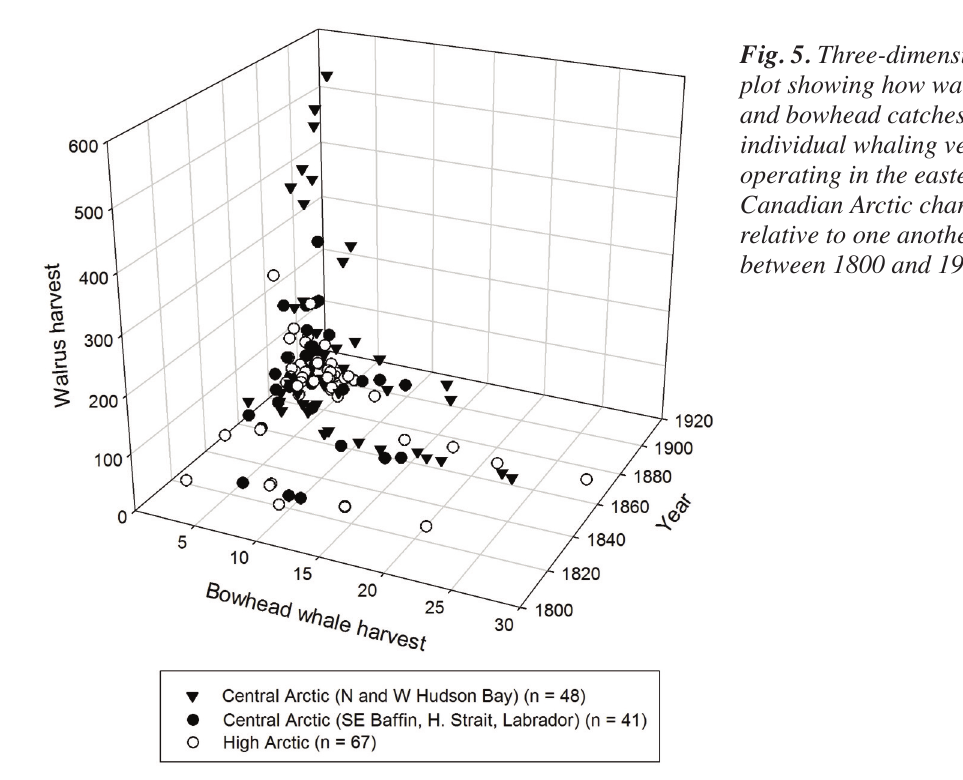
Fig. 5. Three-dimensional plot showing how walrus and bowhead catches by individual whaling vessels operating in the eastern Canadian Arctic changed relative to one another between 1800 and